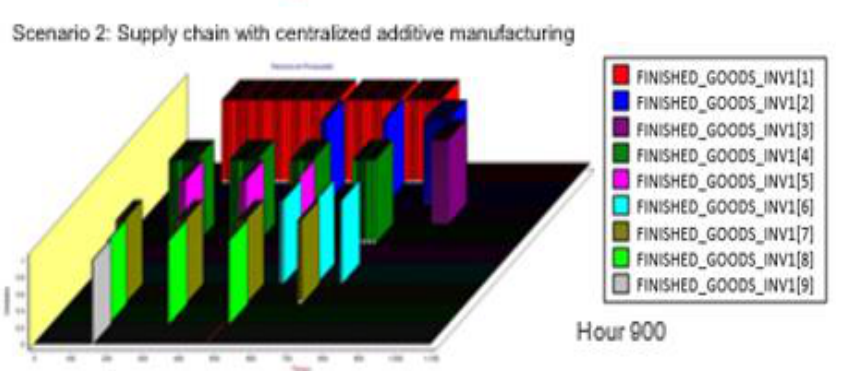
Figure 16. Behavioral contrast of production orders in the established scenarios. Source: own elaboration. Simulation results obtained from Evolution software.